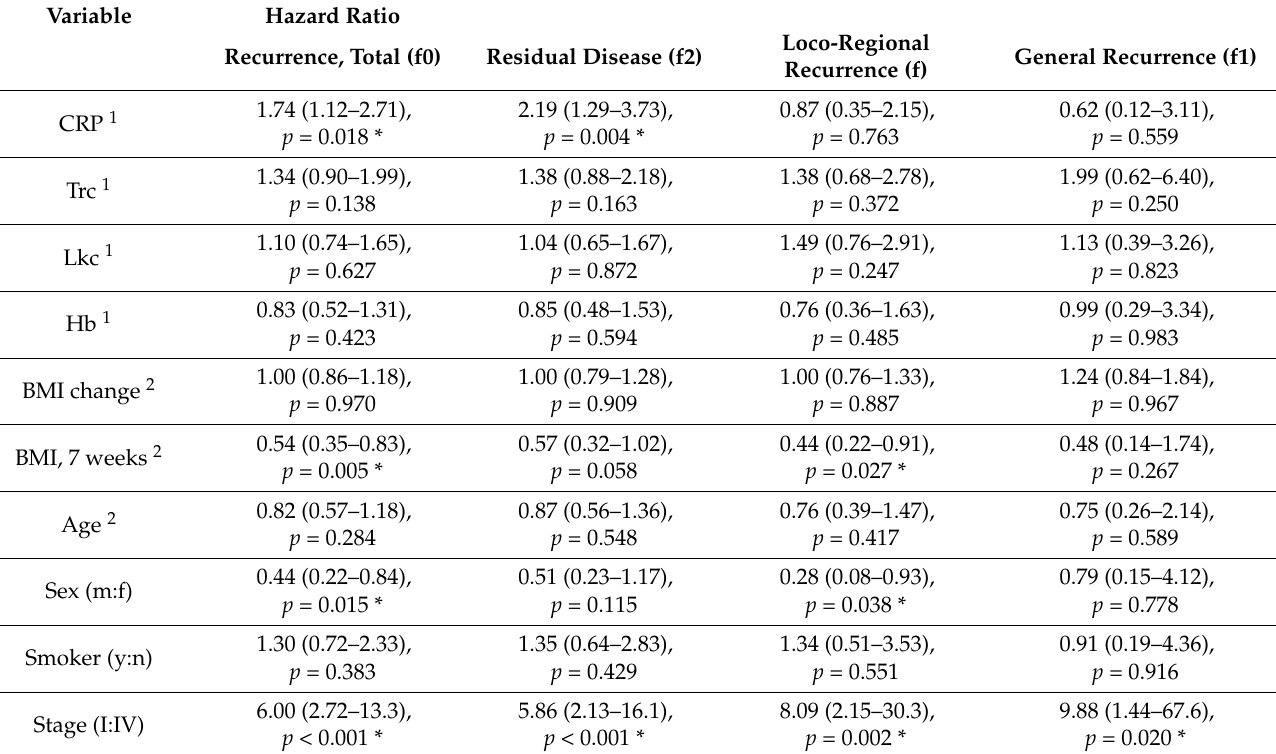
Table 4. Hazard ratios for selected variables and factors in the Cox regression